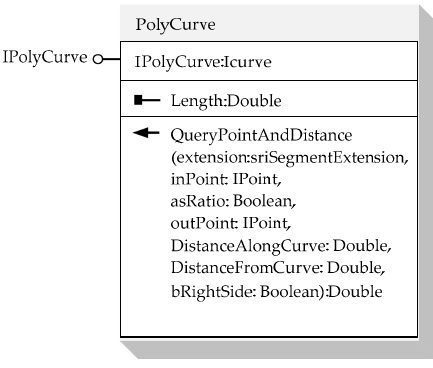
Figure 4. Object Model Diagram (OMD) of PolyCurve component.